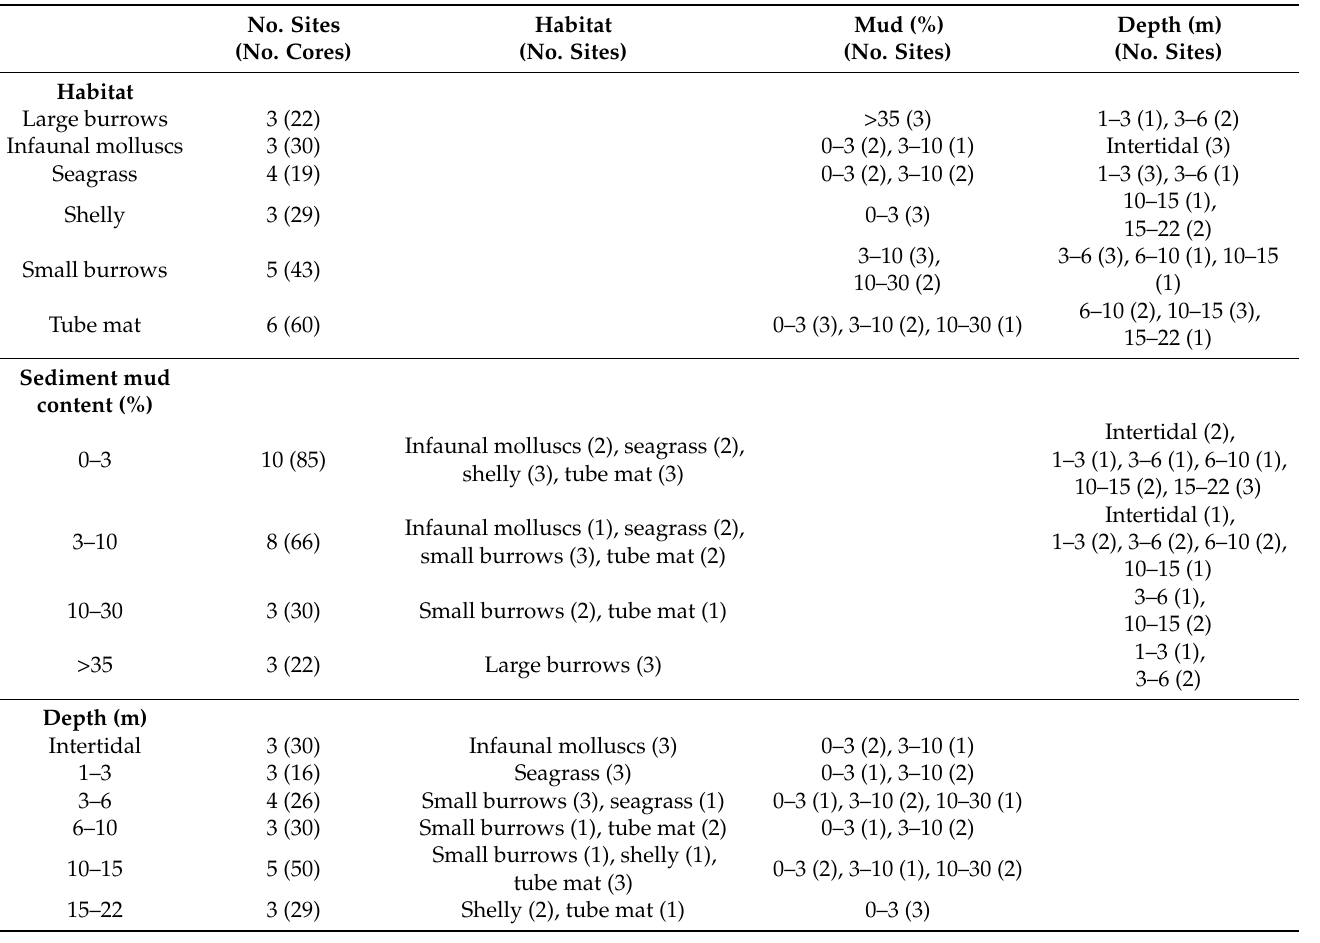
Table 1. The number of sites and individual core replicates within each of the habitat, mud and depth categories. N.B. the three sites with >35% mud were excluded from the depth categories to deconfound the role of mud when investigating